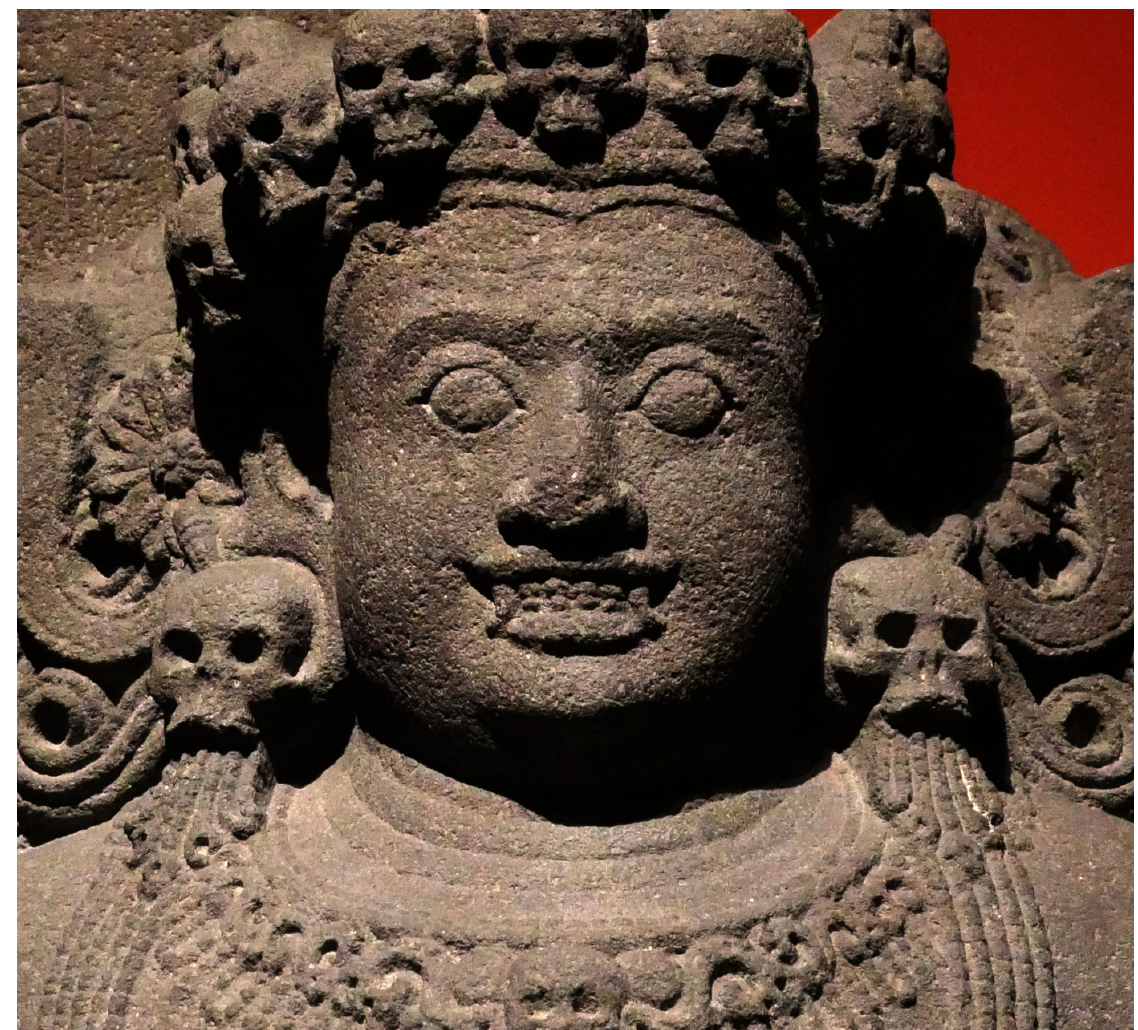
Figure 8 Cakracakra (Bhairavakṣetrapāla), Candi Singosari, Eastern Java (detail). Siṅhasāri period. Rijksmuseum voor Volkenkunde, Leiden, RV-1403-1680. Source: author,